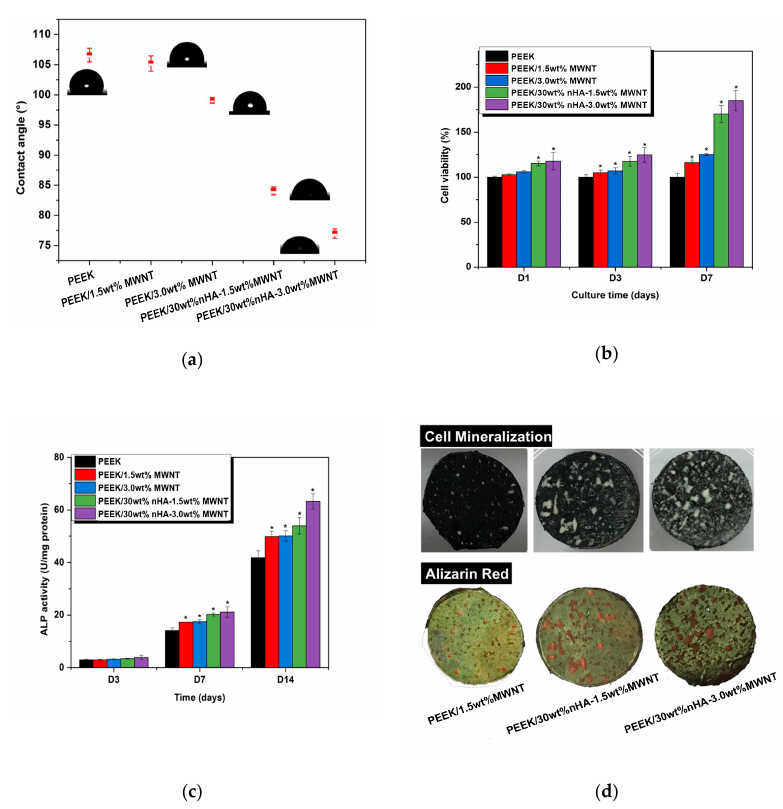
Figure 26. ( a ) Water contact angle values of pure PEEK, PEEK/MWNT nanocomposites and PEEK/nHA-MWNT hybrids. ( b ) WST-1 assay results showing cell viability of murine MC3T3-E1 pre-osteoblasts cultured on PEEK, PEEK/MWNT nanocomposites and PEEK/nHA-MWNT hybrids for 1, 3 and 7 days. * represents p < 0.05. ( c ) ALP activity normalized to protein content of MC3T3-E1 cells cultured on PEEK, PEEK/MWNT nanocomposites and PEEK/nHA-MWNT hybrids for different time points. ( d ) Photographs showing calcium mineralization (before staining) on PEEK/1.5 wt%MWNT, PEEK/30 wt%nHA-1.5 wt%MWNT and PEEK/30 wt%nHA-3.0 wt%MWNT specimens cultivated with MC3T3-E1 cells for 28 days (top panel); Calcified nodules on these specimens exhibit dark red appearance after staining with Alizarin red-S (bottom panel). Reproduced from [63] with permission of MDPI under the terms and conditions of the Creative Commons Attribution license.